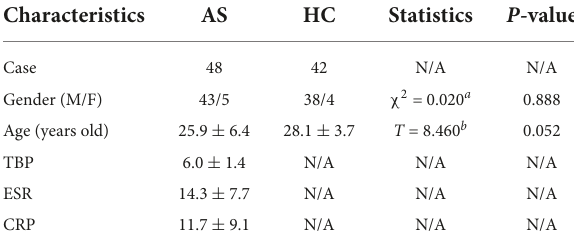
TABLE 1 Demographic and clinical data